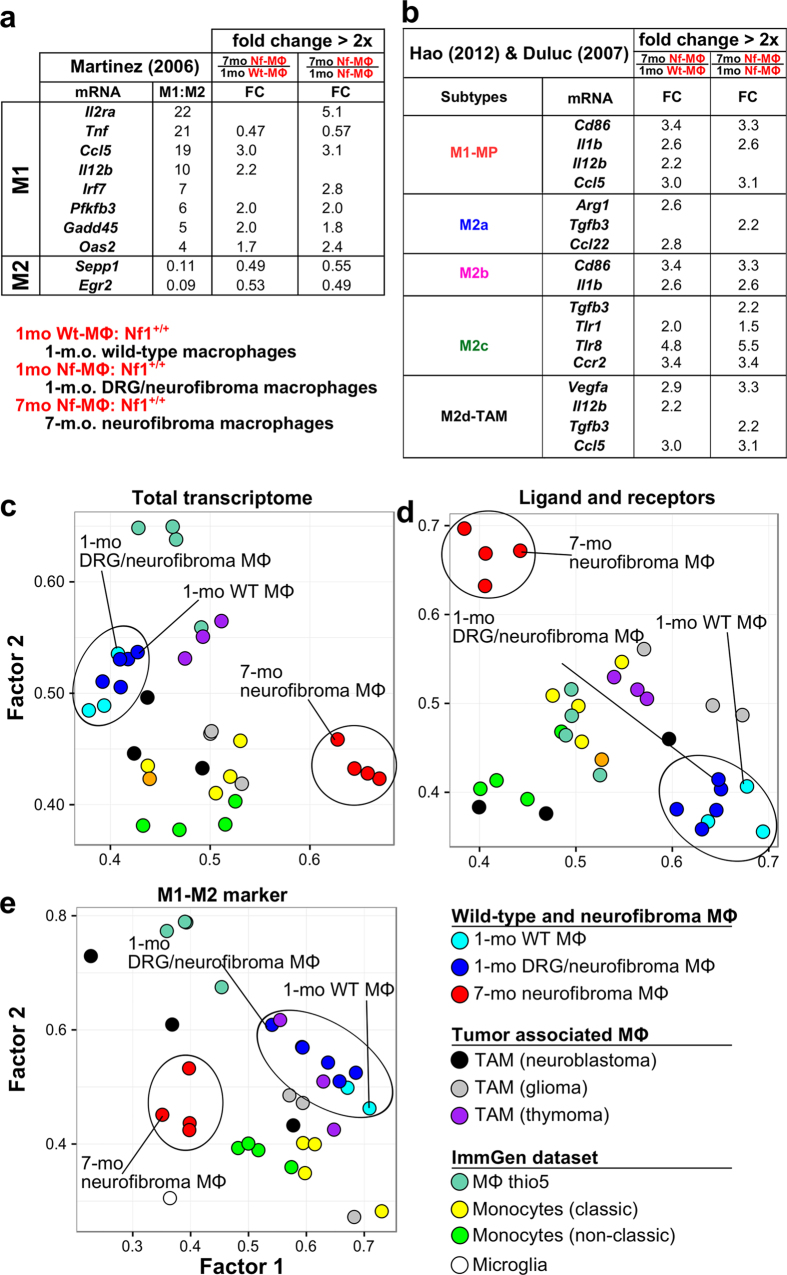
Characteristics of 7 neurofibroma macrophages.DEGs from 7-to-1 month comparison of macrophages (a,b) were mapped to M1/M2 polarization signature genes collected from previous publications. Only differentially expressed signature genes were displayed. Macrophage (MΦ) subpopulation clusters were generated by exploratory factor analysis (EFA) approach, based on (c) all genes in the microarray, (d) ligands and receptor genes, and (e) M1/M2 signature genes19.